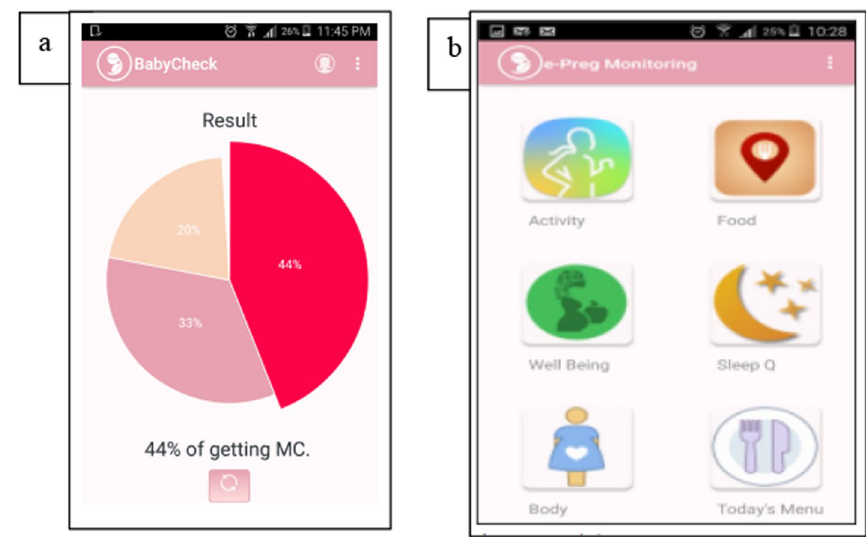
Fig. 8 a Results in Doctor Profile b List of recommendations for pregnant